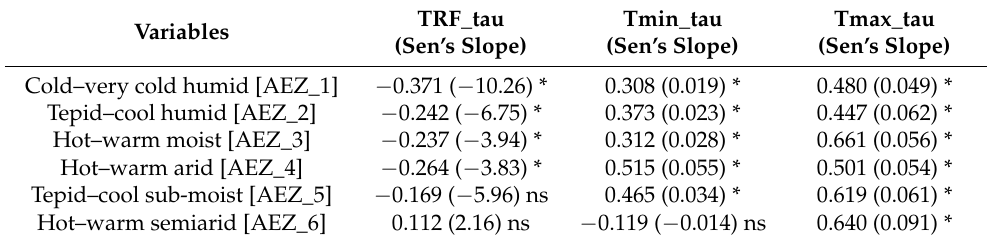
Table 1. Annual trends of TRF, Tmin and Tmax across agroecologies (1983 −